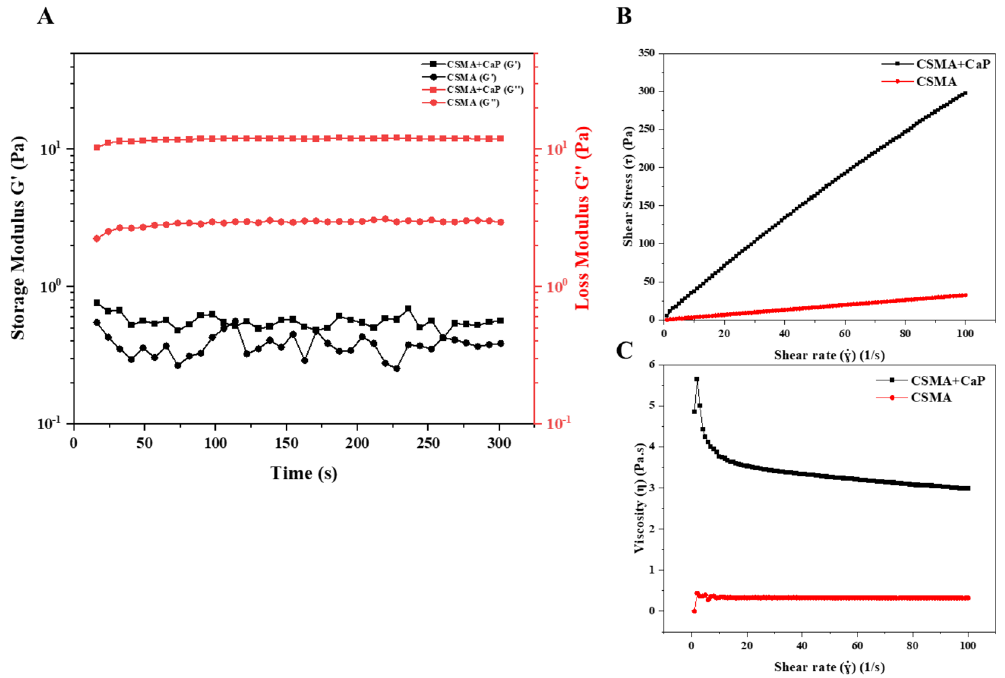
Figure 7. Rheological analyses of CSMA and CSMA + CaP ( A ) storage and loss modulus analyses ( B , C ) flow behaviour of the materials shear rate dependant viscosity and shear stress